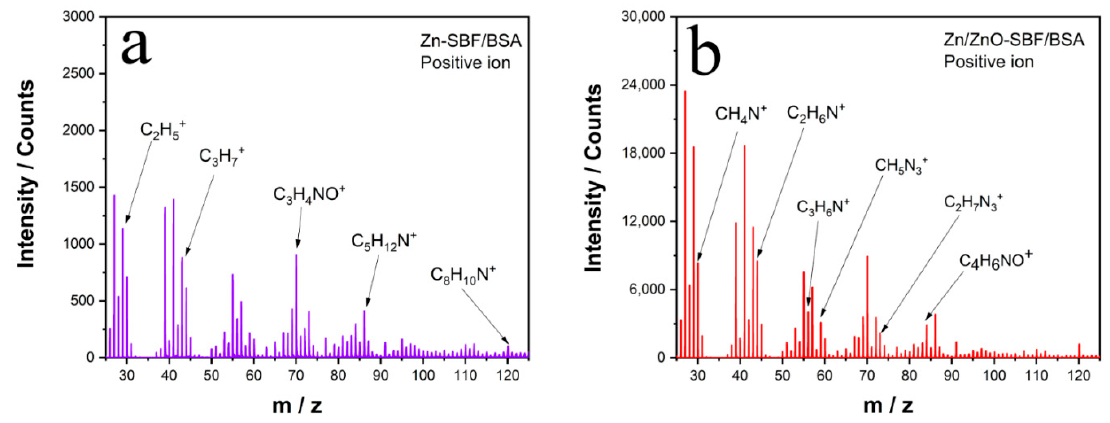
Figure 11. TOF-SIMS measurement of samples after immersion in SBF/BSA: ( a ) Zn, ( b ): Zn/ZnO.